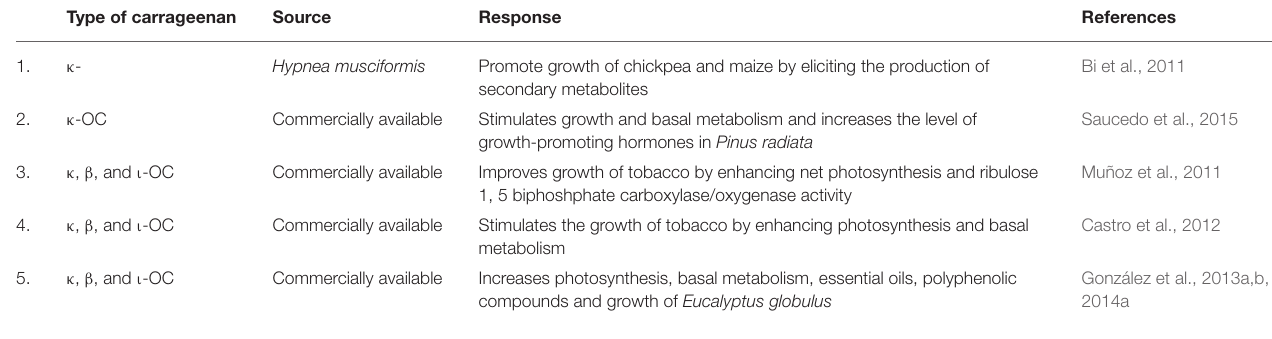
TABLE 1 | Role of carrageenans in plant growth promotion.